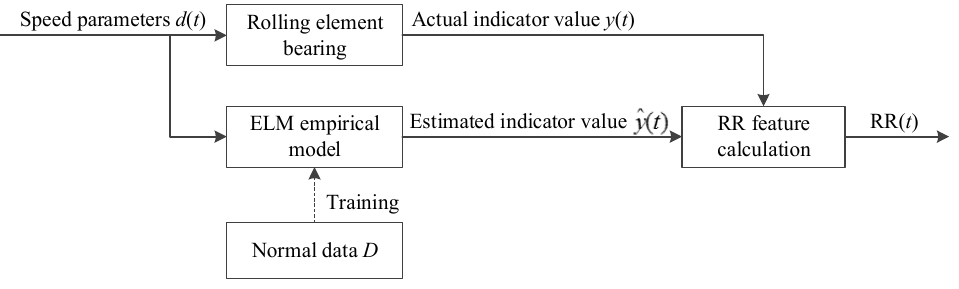
Figure 4. Variation of feature values with the increase of speed under normal and fault states: ( a ) Std of IHC; ( b ) RMS.